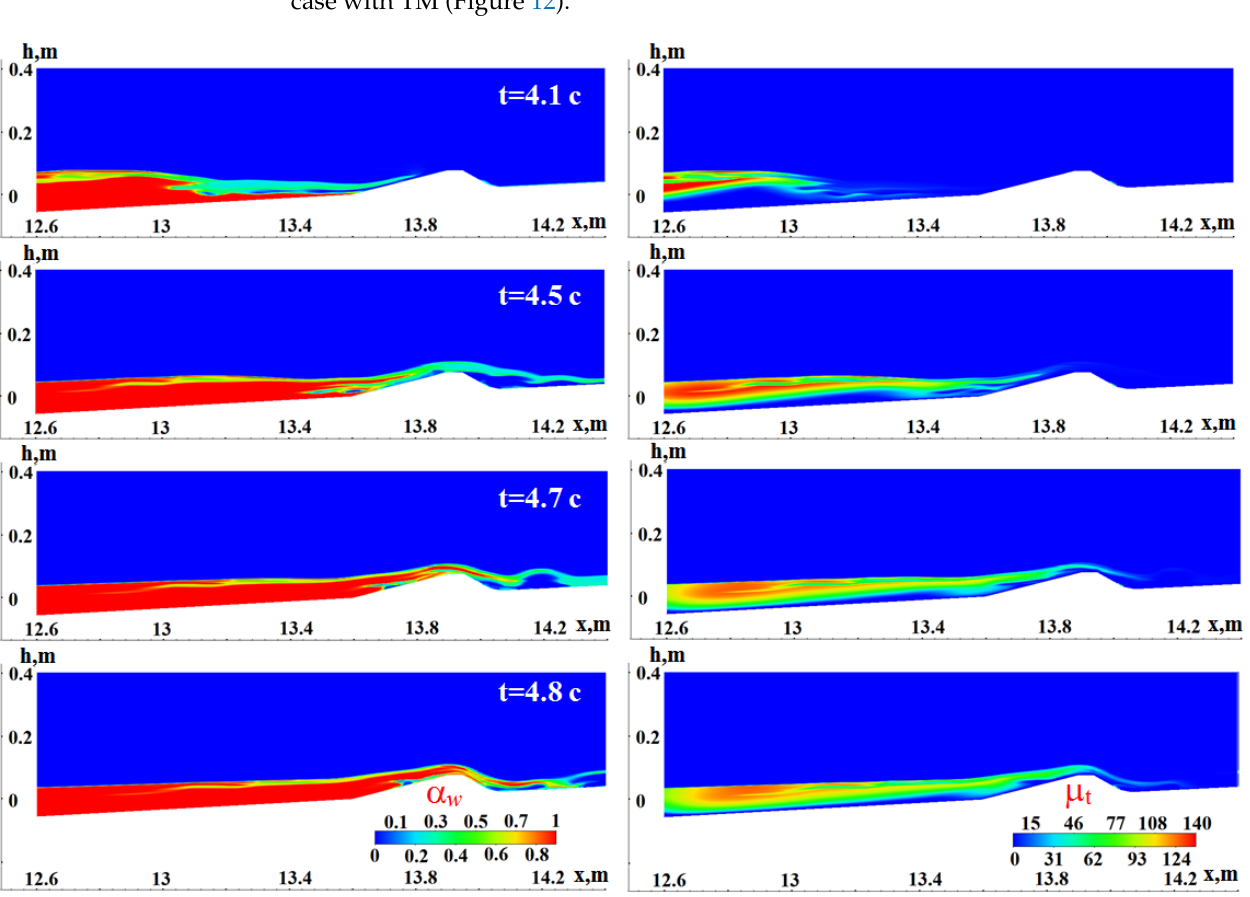
Figure 11. Comparison of the wave profiles for setup 4 ( —without TM, —with TM).